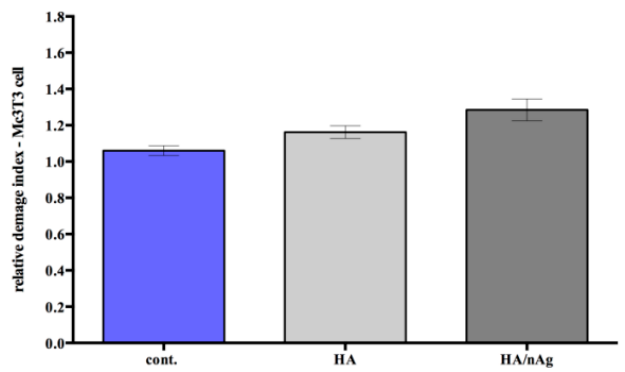
Figure 7. DNA damage in the osteoblast-like cells (MC3T3-E1). Molecules 2017 , 22 , 1291